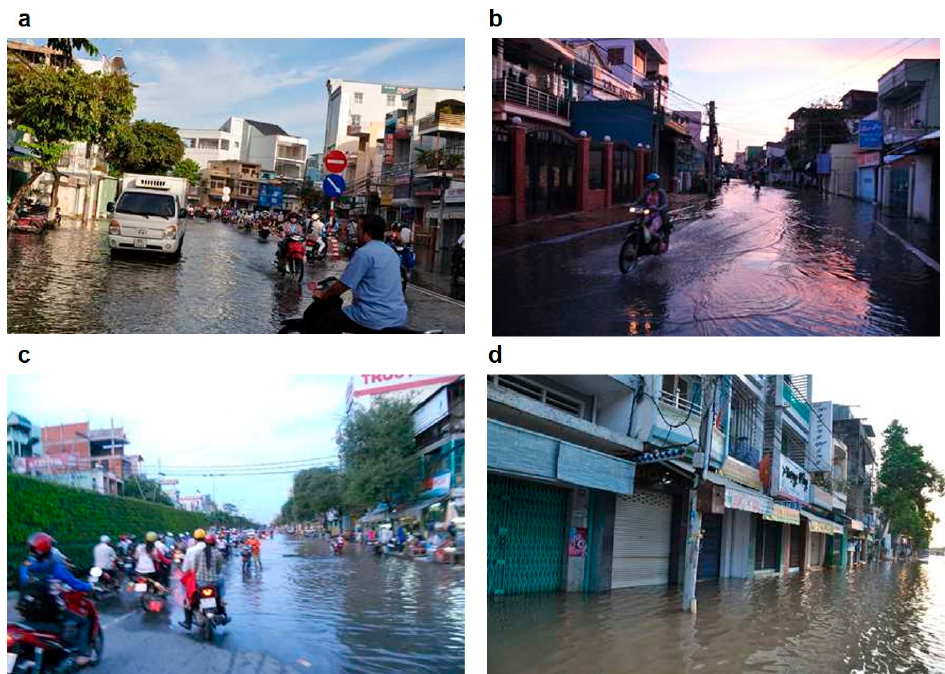
Figure 4. ( a – d ) Photographs showing the different inundated areas in Can Tho City during the floods in the year 2014 (Courtesy: Dr Dunja Krause, United Nations Research Institute for Social Development (UNRISD, Geneva,